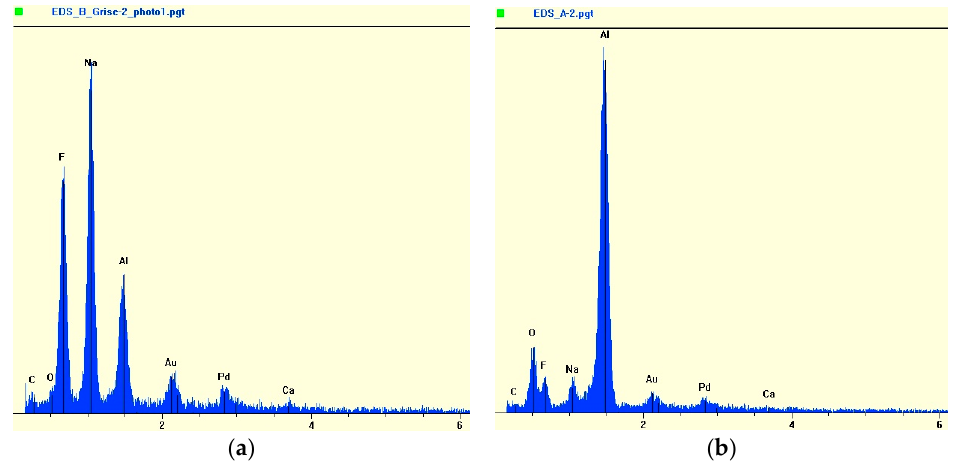
Figure 9. Typical results of EDS (energy-dispersive X-ray spectroscopy) analysis: ( a ) Smooth and homogeneous zones; ( b ) flaky zones.